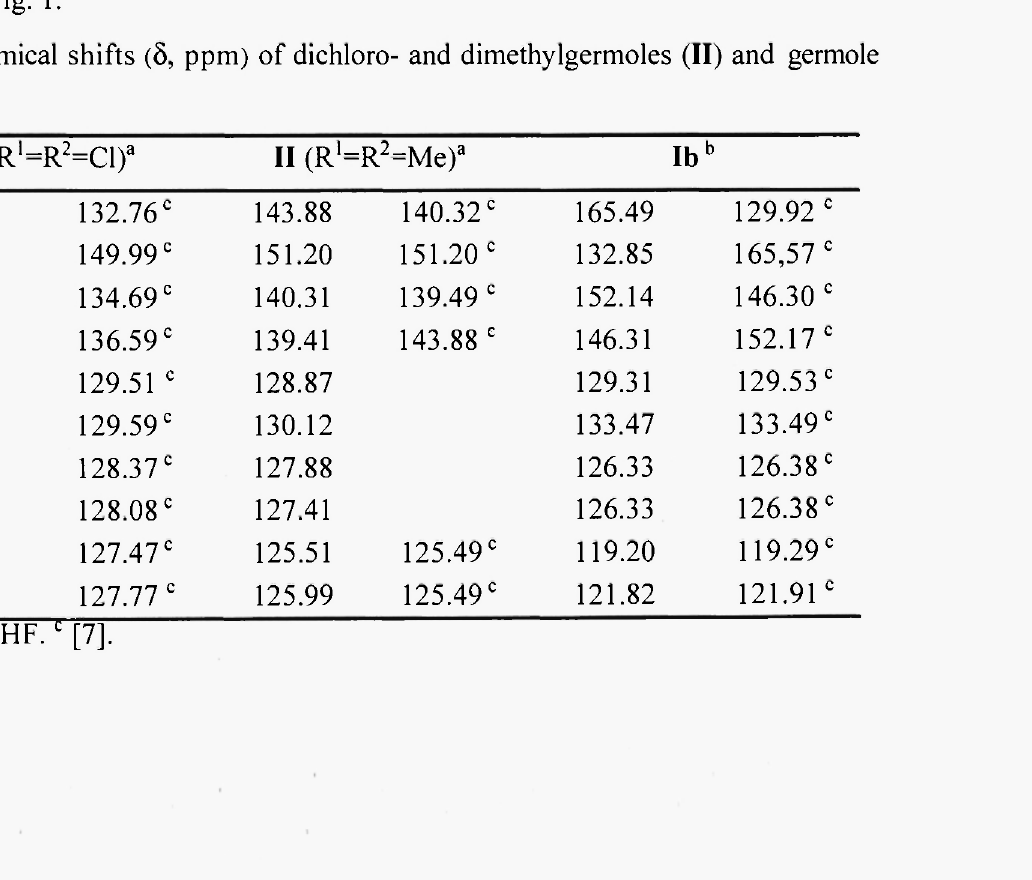
Table 1. 13 C chemical shifts (δ, ppm) of dichloro- and dimethylgermoles (II) and germole dianion